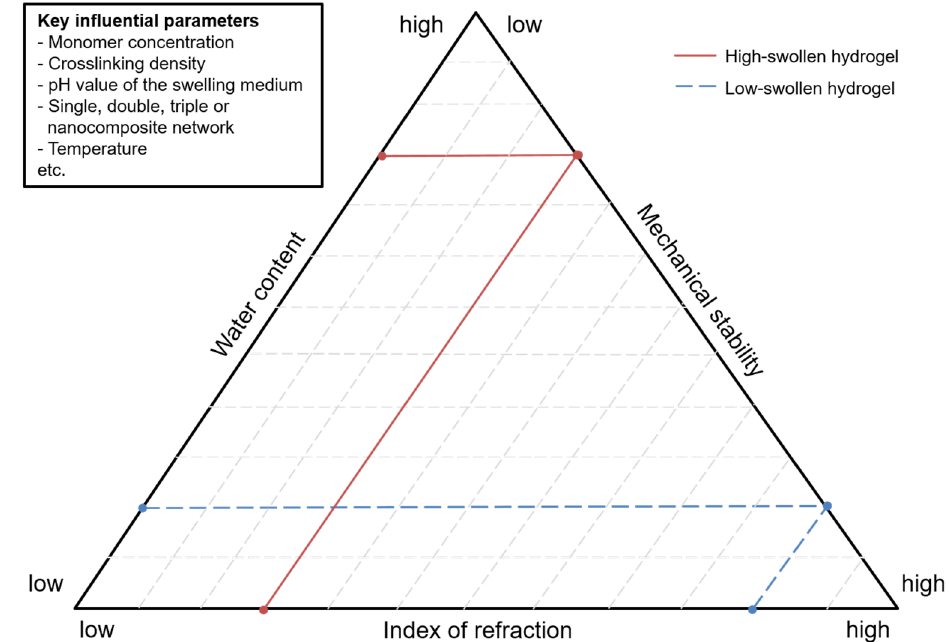
Figure 7. Triangular diagram to visualize the relation among the water content (swelling), mechanical stability, and IOR of the high- and low-swollen hydrogels with the key influential parameters of monomer concentration; cross-linking density; pH value; single, double, triple, or nanocomposite networks; and temperature.